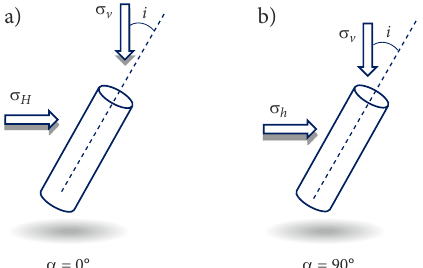
Figure 6. Oriented borehole and in situ stresses conditions: